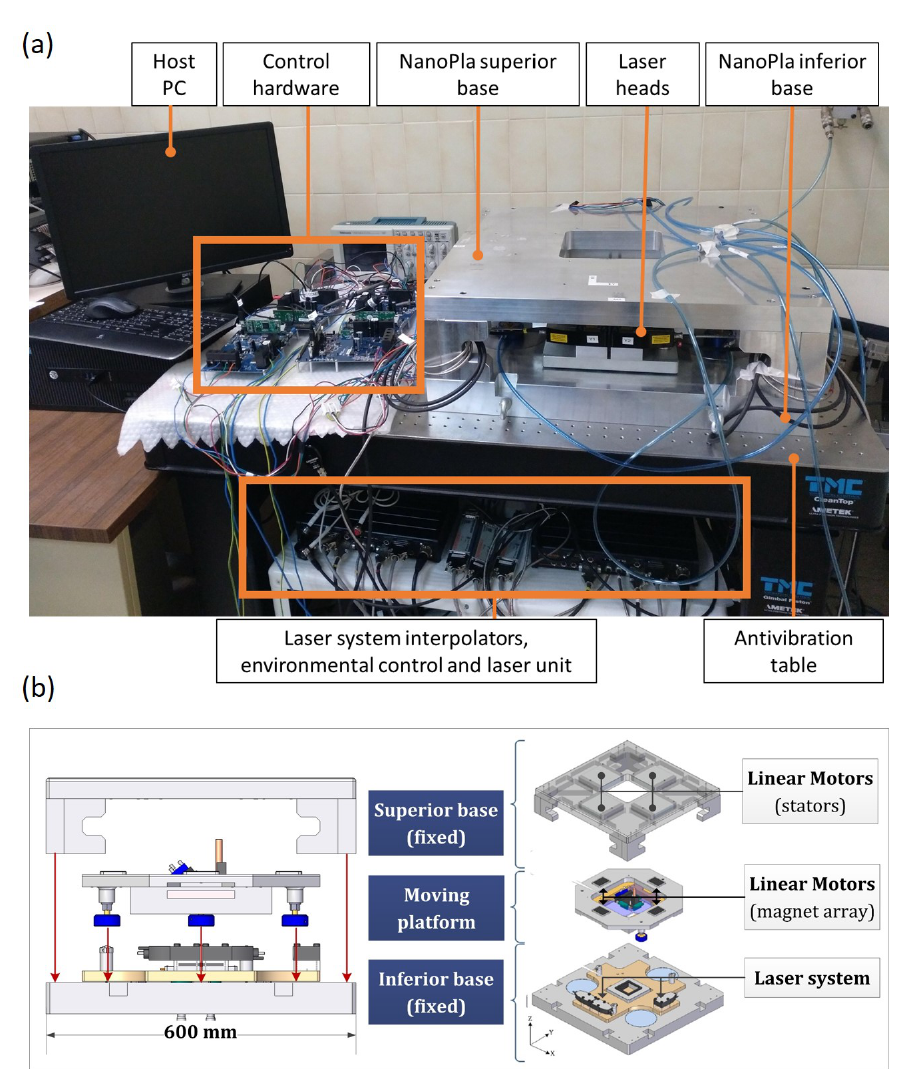
Figure 3. ( a ) Photograph of the NanoPla and the control system components; ( b ) front and exploded view of the